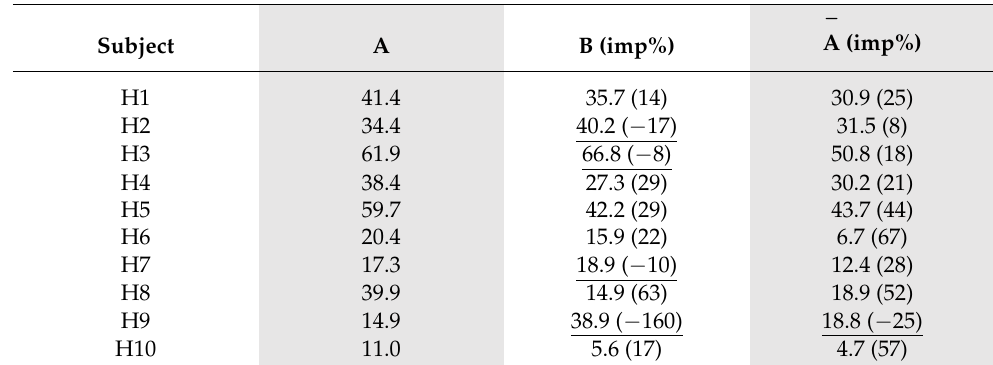
Table 4. The asymmetry of the swing